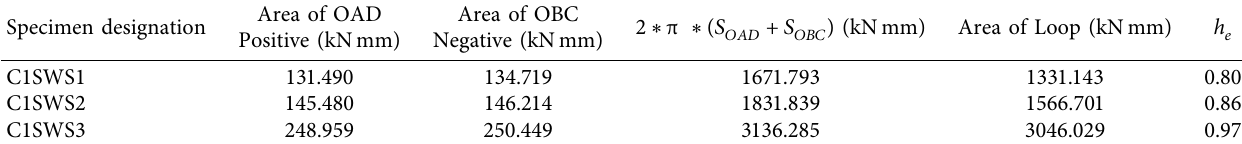
Table 5: Cumulative energy dissipation and viscous damping ratio of U-type connection.